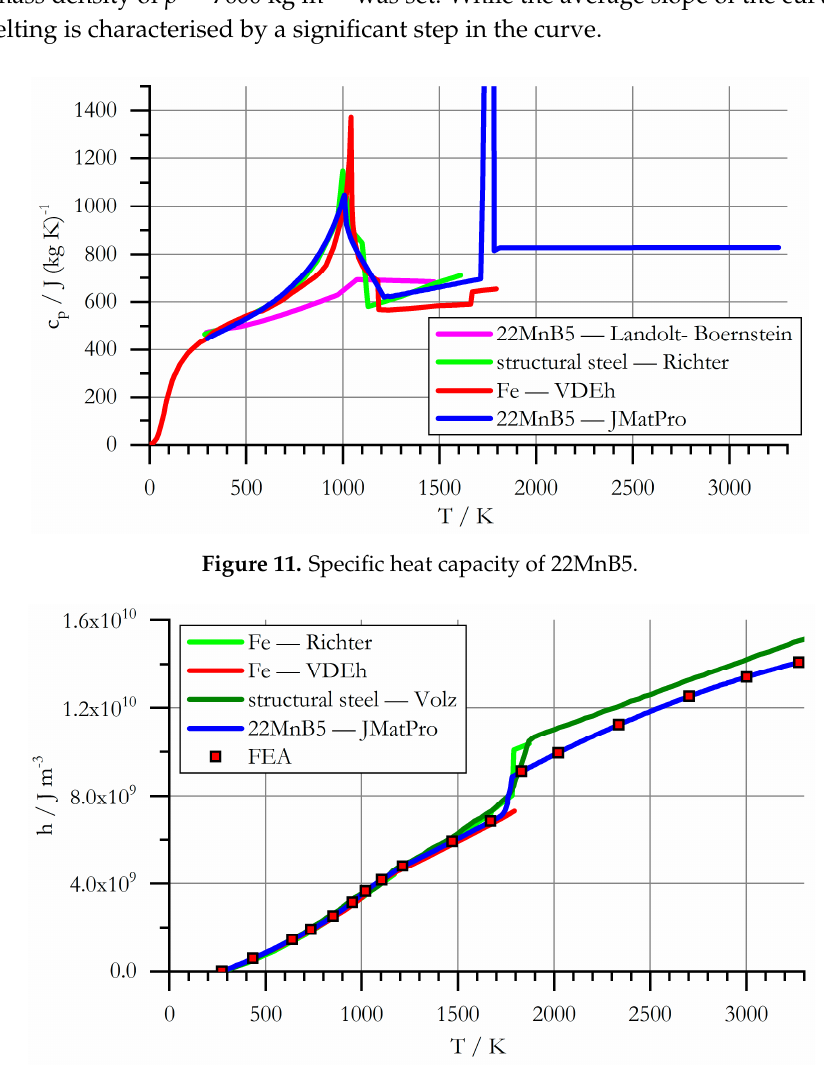
Figure 12. Specific enthalpy density of 22MnB5.